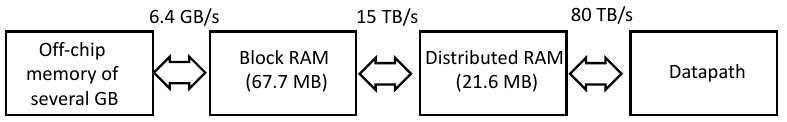
Figure 1. Bandwidth/memory distribution in Xilinx Virtex-7 FPGA which highlight how bandwidth and computation improves as we near the datapath parts of the